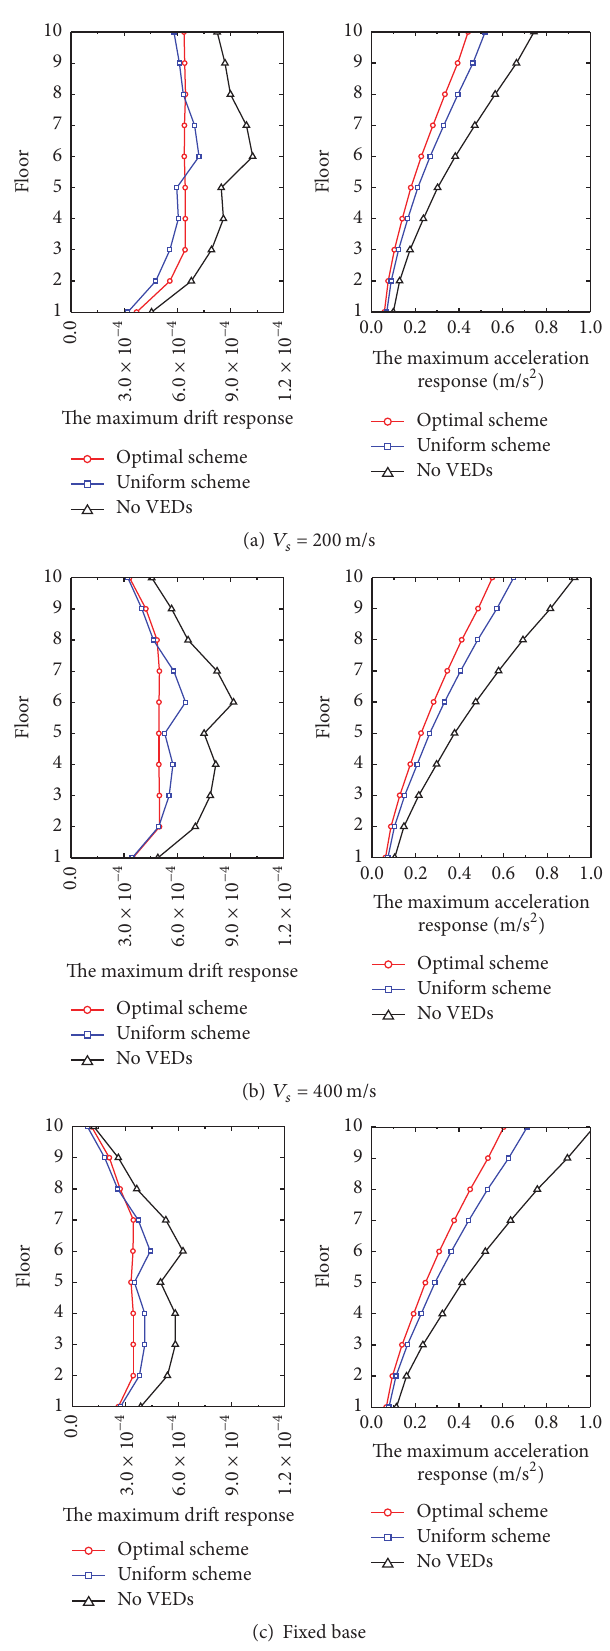
Figure 15: The comparison of structural responses for different distribution of VEDs (10-story